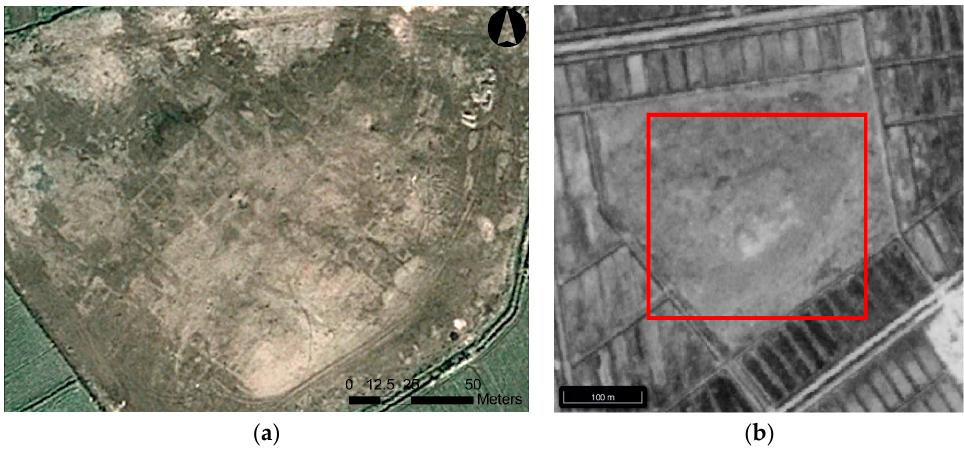
Figure 16. ( a ) The site of Kom el-Garad. Image courtesy Google Earth; ( b ) 1968 CORONA image. The area of image ( a ) is within the red box. Image courtesy of the Center for Advanced Spatial Technologies, University of Arkansas/U.S. Geological Survey.